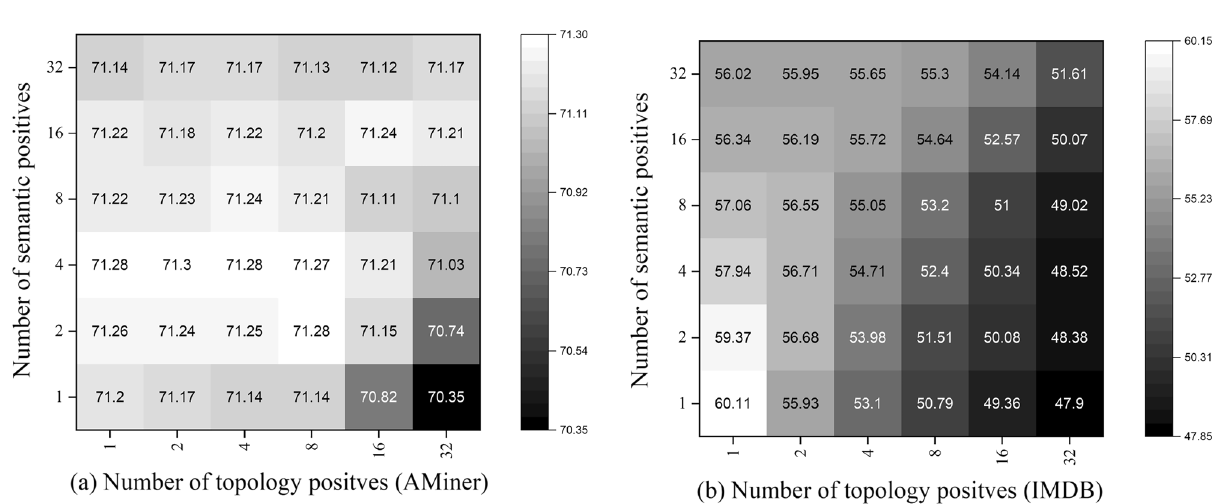
Figure 4. Hyperparameter sensitivity of positive sampling thresholds on node classification (AMiner and